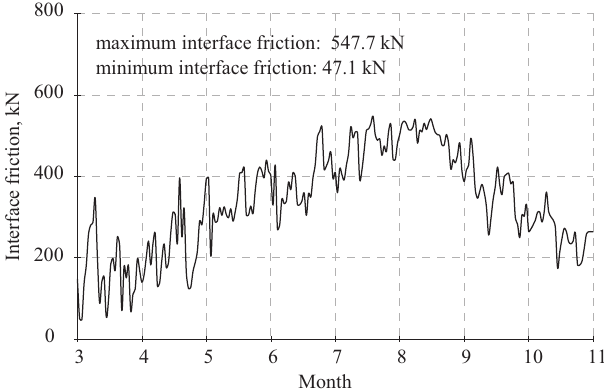
Figure 12. The interface friction in the